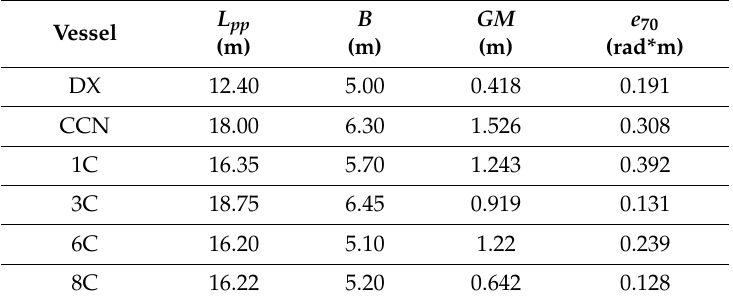
Table 1. Vessel database.